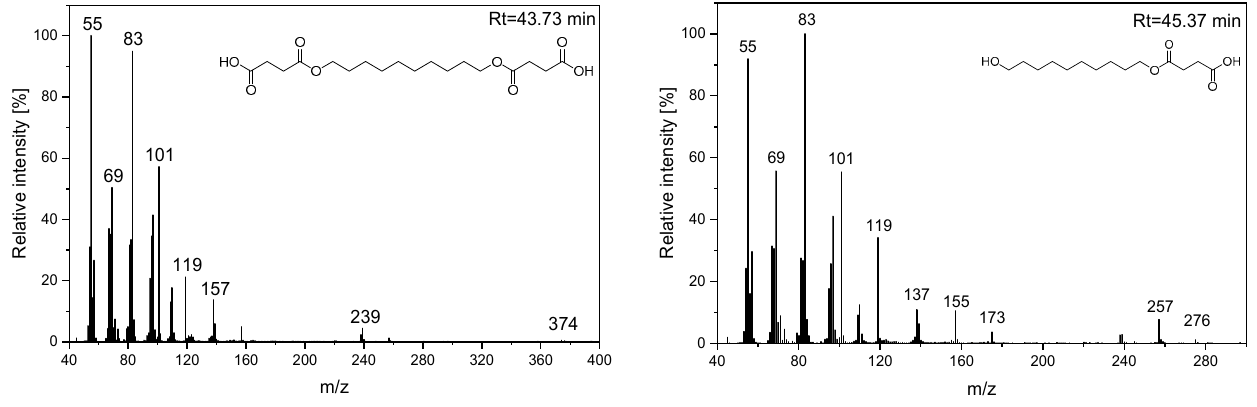
Figure 6. Mass spectra of the major decomposition products of POSu. Table 7. Thermal decomposition products of PDeSu.